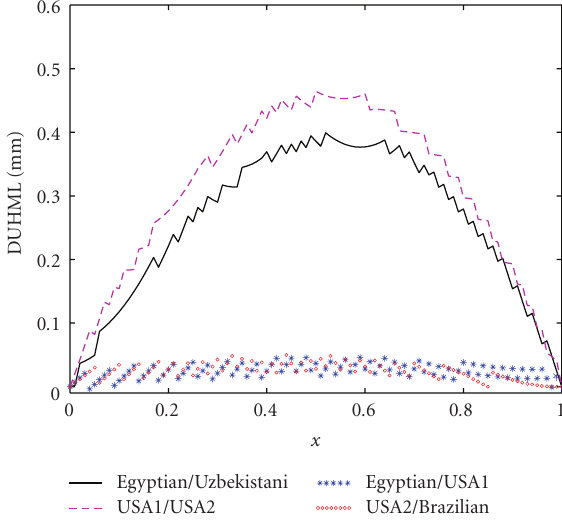
Figure 5: DUHML dependence to x .